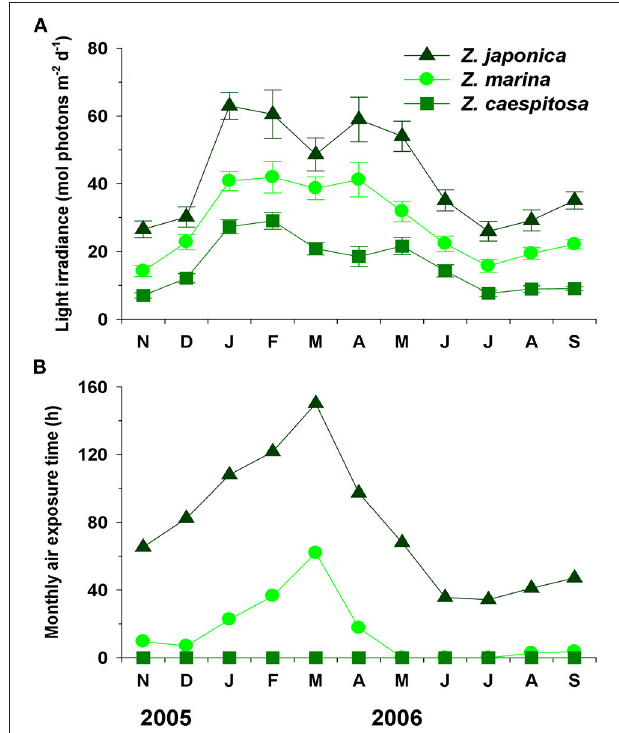
FIGURE 2 | Seasonal variations in light irradiance (A) and monthly air exposure time (B) and at the three study zones in Koje Bay. Values are expressed as mean ± SE ( n = 26–31) for light